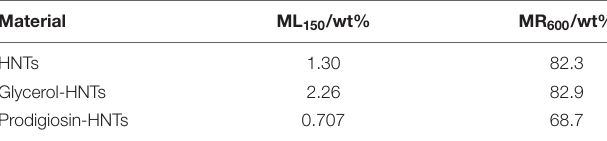
TABLE 1 | Thermogravimetric parameters for HNTs, glycerol-HNTs and